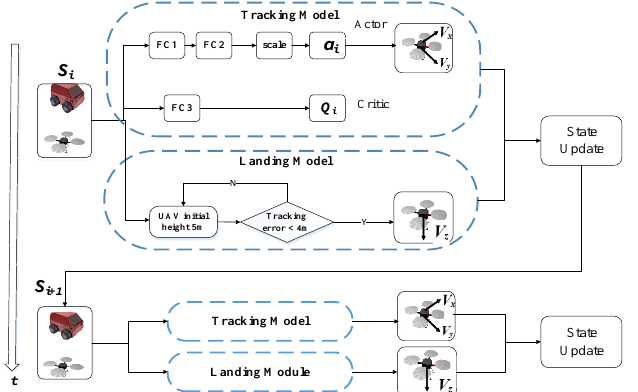
Figure 4. Hybrid strategy consisting of two parts: tracking and landing modules. The tracking module introduces the deep reinforcement learning method, and the landing module adopts heuristic rules, so as to land the UAV on the platform.